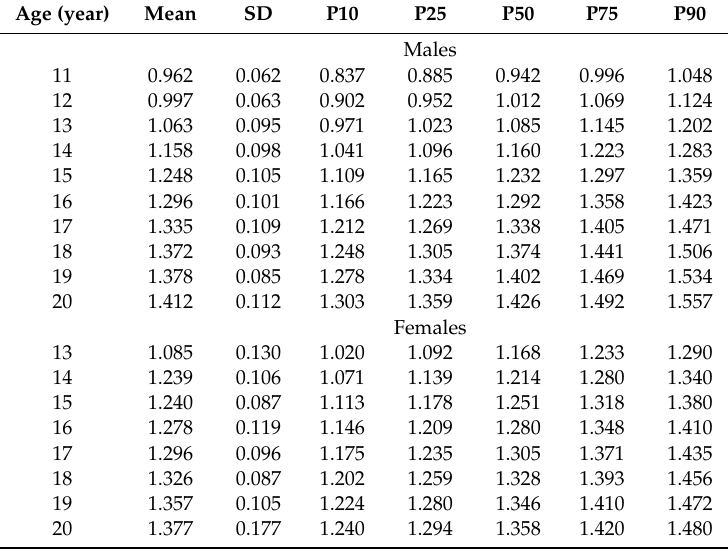
Table A1. Basic statistical parameters (mean, SD, and 10th, 25th, 50th, 75th, and 90th percentiles) for total BMD (g / cm 2 ) in youth male and female athletes.